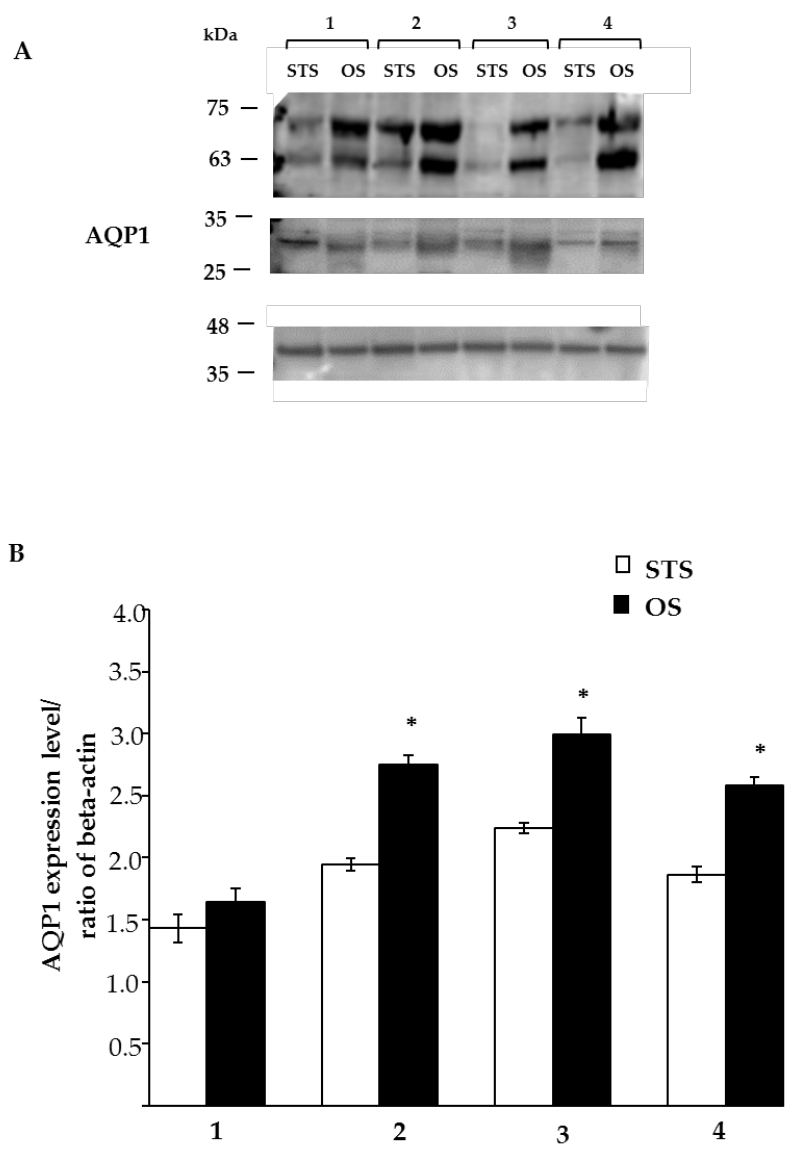
Figure 6. Representative Western blot of AQP1 protein isolated from tears collected by the STS and OS methods. ( A ) Image is representative of three distinct experiments performed on four dogs (lanes 1–4). The expression of AQP1 was normalised against that of β –actin. ( B ) Densitometric analysis of AQP1